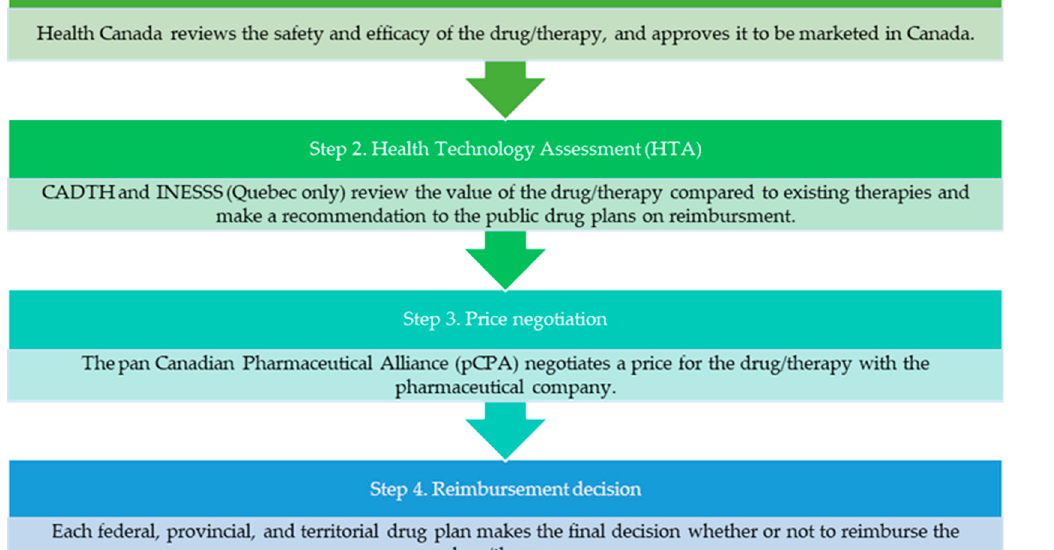
Figure 1. Drug reimbursement process in Canada. Abbreviations: CADTH, Canadian Agency for Drugs and Technologies in Health; INESSS, Institut National d’Excellence en Sante et Services Sociaux.